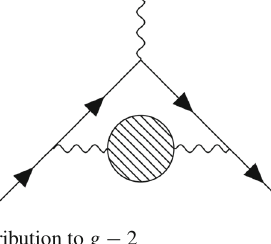
Fig. 2 HVP contribution to g − 2